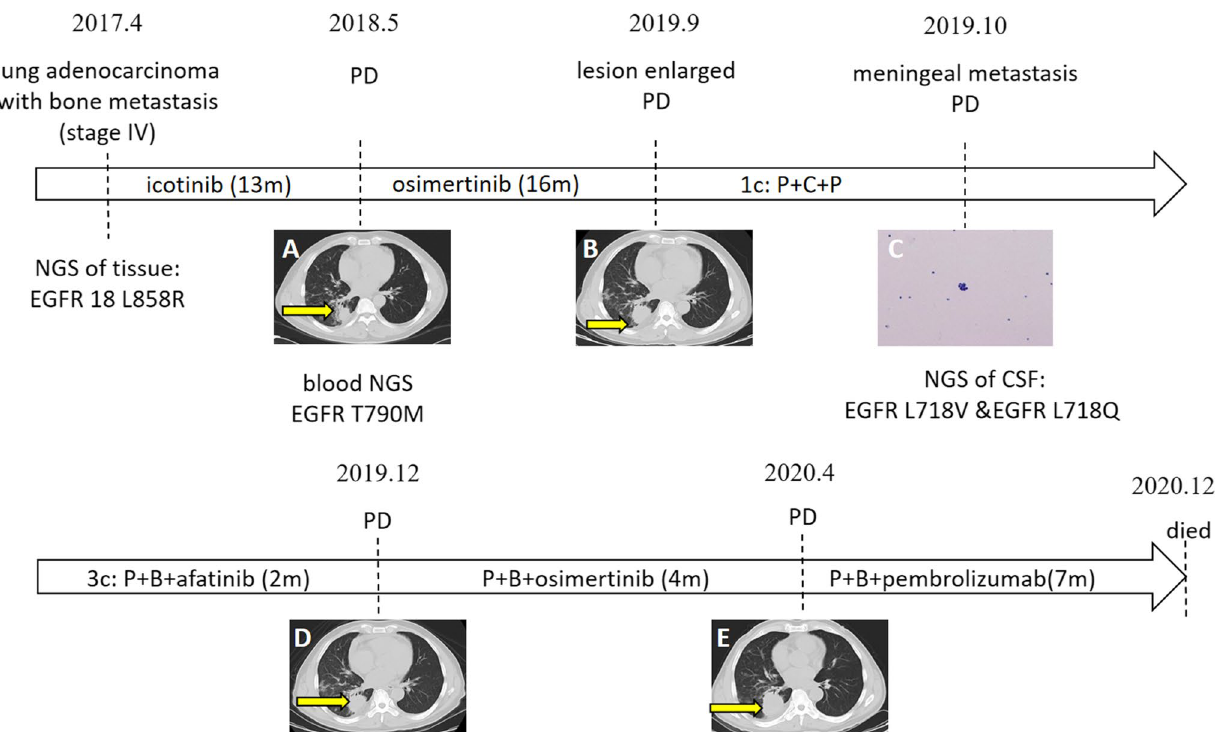
Fig. 1 Detailed diagnosis and treatment procedures of Case1. The patient complained of chest tightness and shortness of breath after going upstairs and was diagnosed with lung adenocarcinoma and bone metastasis (stage IV) at other medical centers in April 2017. L858R mutation in exon 21 of EGFR was revealed by lung puncture biopsy. Icotinib was applied for 13 months, and the best curative effect was partial response (PR). The concentration of serum CEA and re-examination in May 2018 via computerized tomography (CT) showed dis- ease progression (PD). The mutation was confirmed to be EGFR T790M through genetic testing of the blood, since the patient was unwill- ing to undergo another biopsy ( A ). Osimertinib was administered daily for 16 months and PR was achieved with good physical condition. CT images in September 2019 showed PD ( B ). Pemetrexed (500 mg/m 2 ) combined with carboplatin (area under the curve ¼ 5) plus pem- brolizumab (200 mg) was administered only once since an unexpected syncope before the second treatment on October 8, 2019. Menin- geal metastasis was diagnosed by adenocarcinoma cells found in the cerebrospinal fluid (CSF) obtained from a lumbar puncture ( C ) and enhanced magnetic resonance image (MRI). Genetic testing indicated the presence of the L718V (c.2152C > G (p.L718V), 7.7%) and L718Q (c.2153 T > A (p.L718Q), 1.6%) mutations of EGFR exon 18. Pemetrexed combined with bevacizumab (15 mg/kg) plus afatinib was adminis- tered for three cycles, and the best response achieved stable disease (SD). CT performed in December 2019 showed PD ( D ). Subsequently, pemetrexed in combination with bevacizumab (15 mg/kg) plus osimertinib was applied for four months in which myelosuppression occurs. Due to progression in April 2020 ( E ), the patient was treated with pemetrexed combined with bevacizumab plus pembrolizumab until November 2020 on account of intolerance to any kind of treatment. The patient died of cachexia on December 18,